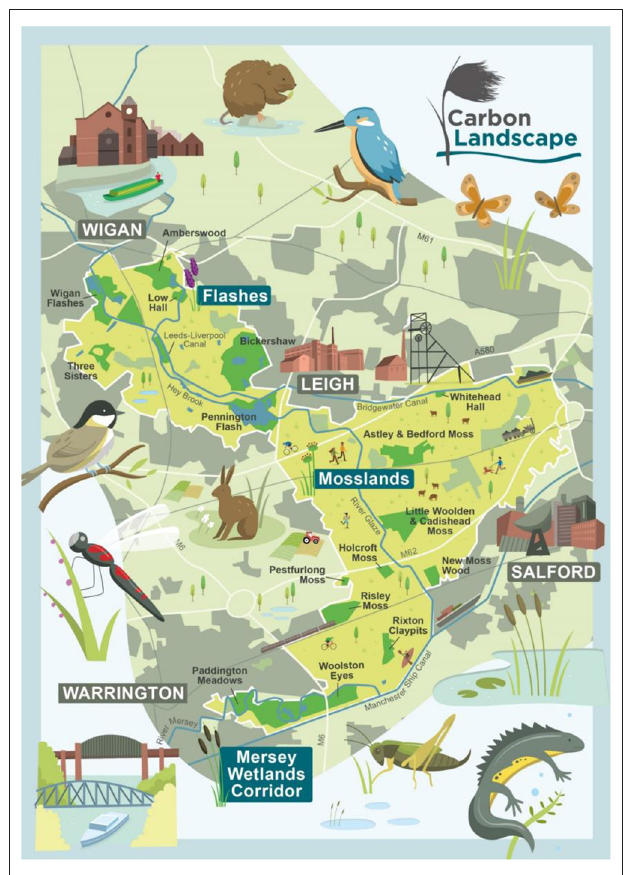
FIGURE 3 | Map used to convey the Carbon Landscape spatial imaginary. Source: Carbon Landscape